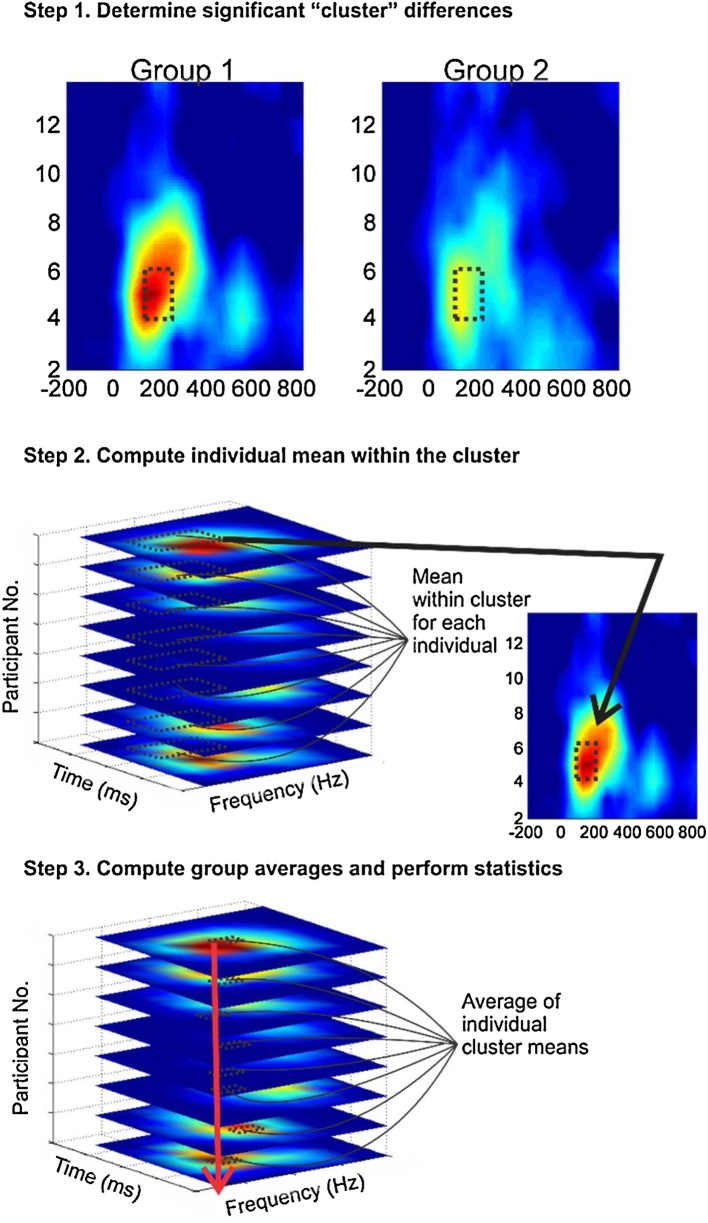
Determination of significant time-frequency “clusters”. Step 1. Significant and stable difference in “clusters” of time and frequency are automatically identified between groups. This figure shows an illustration of individual data matrices to be submitted to statistical analysis. Step 2. The mean value was then calculated within the cluster boundary for each individual. Step 3. A “subcluster” mean was then computed to give the individual data points for ITPL and TSE statistical analysis.